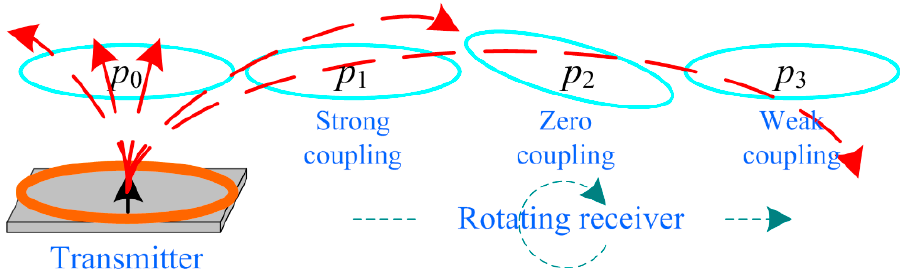
Figure 2. Coupled coils system studied in [23].